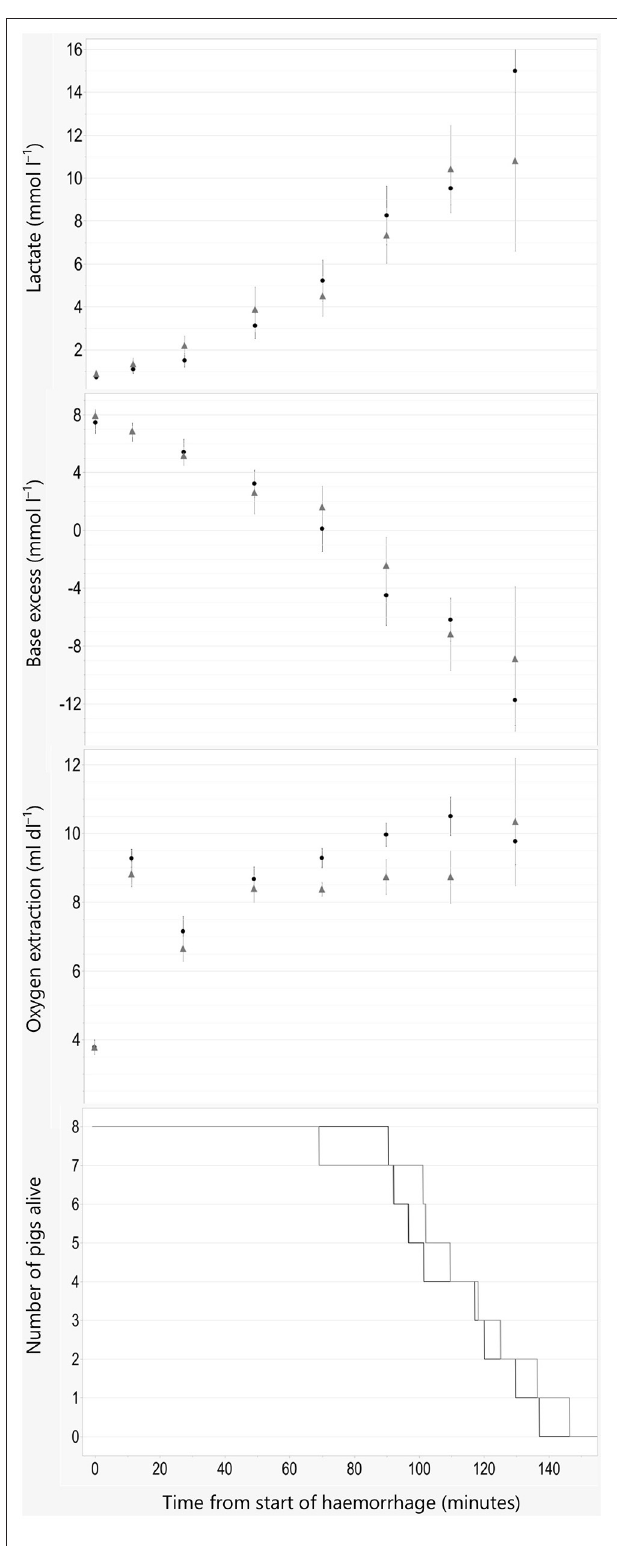
FIGURE 2 | Indices of oxygen debt and time of death. Data are plotted against time in minutes from start of hemorrhage. Arterial blood lactate concentration, base excess, and oxygen extraction are illustrated as Mean ±